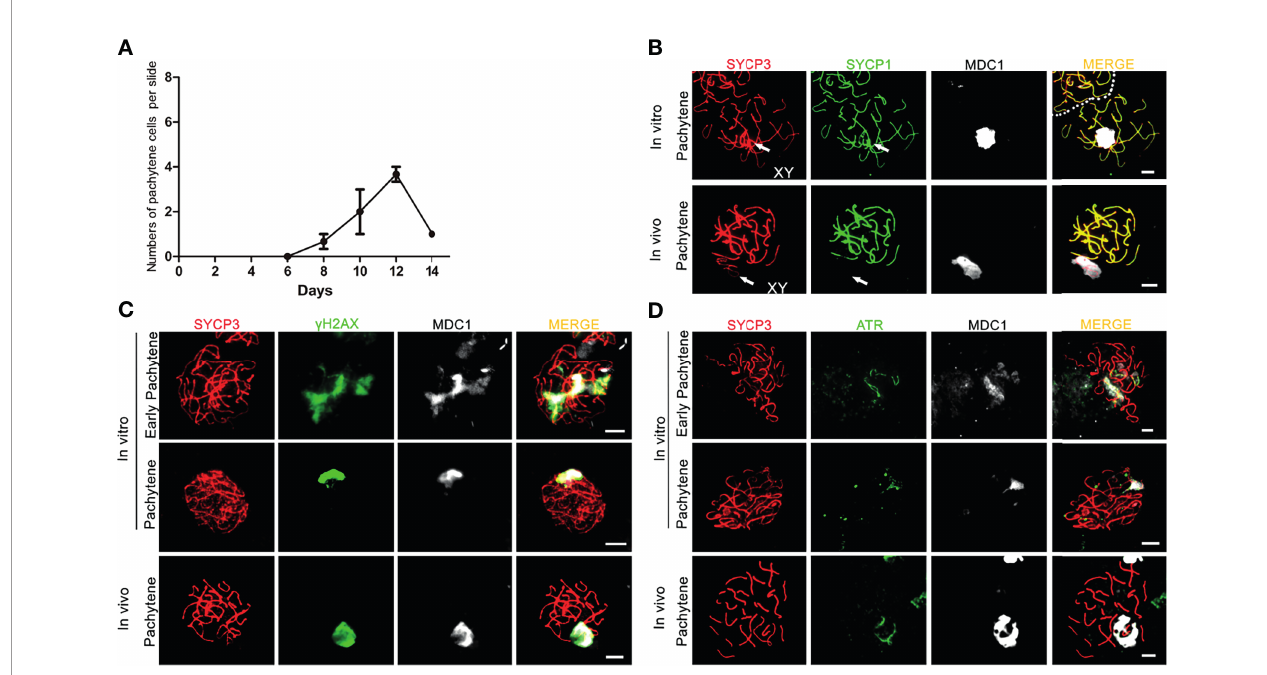
FIGURE 2 | XY body formation during in vitro meiosis. (A) Number of in vitro generated-pachytene cells per microscopy slide. Quanti fi cation for each time point was performed using 3 slides from 3 independent experiments. Data are presented as the mean ± SEM. (B – D) The XY bodies are marked with (B) MDC1, (C) g H2AX and (D) ATR in in vitro - generated early pachytene and pachytene spermatocytes stained for SYCP3 (red) and MDC1 (white), SYCP1(green), g H2AX (green), or ATR (green). In vivo pachytene spermatocytes are used for a positive control. Scale bars,